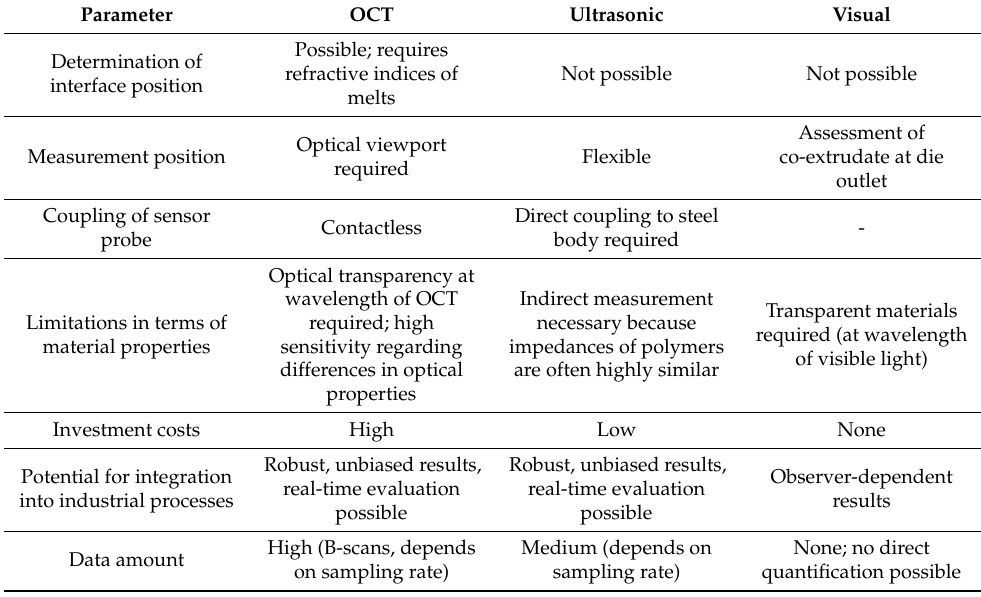
Table 10. Summary of the advantages and features of the detection methods